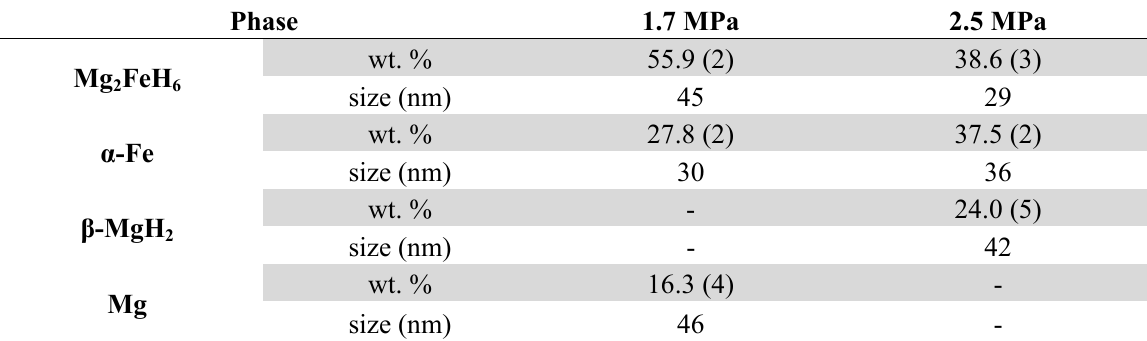
as calculated by 2